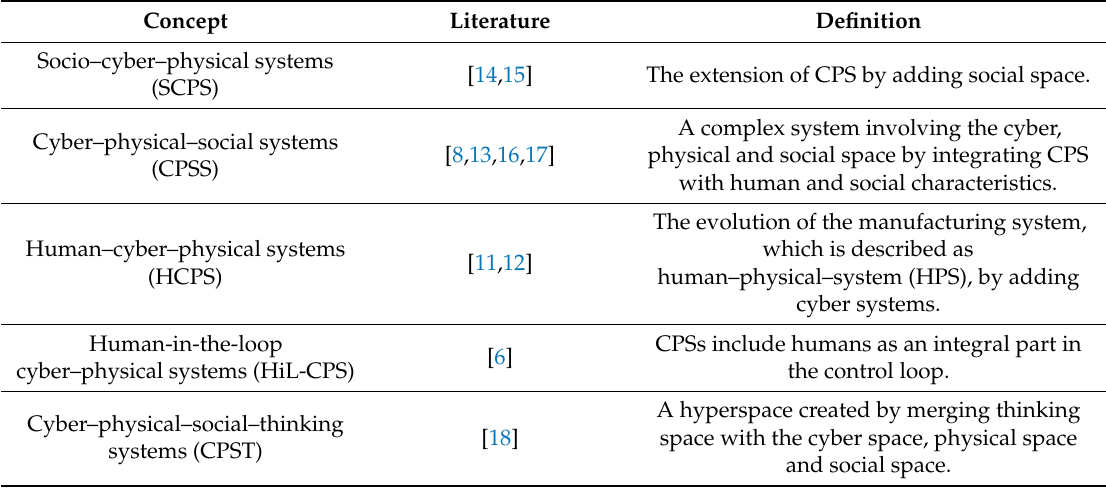
Table 1. CPSS was typically used in energy, power grid, smart home, emergency management, smart vehicles, intelligent transportation system, intelligent manufacturing, and smart city, etc. [7]. Table 1. Definition and research on the cyber–physical–social system